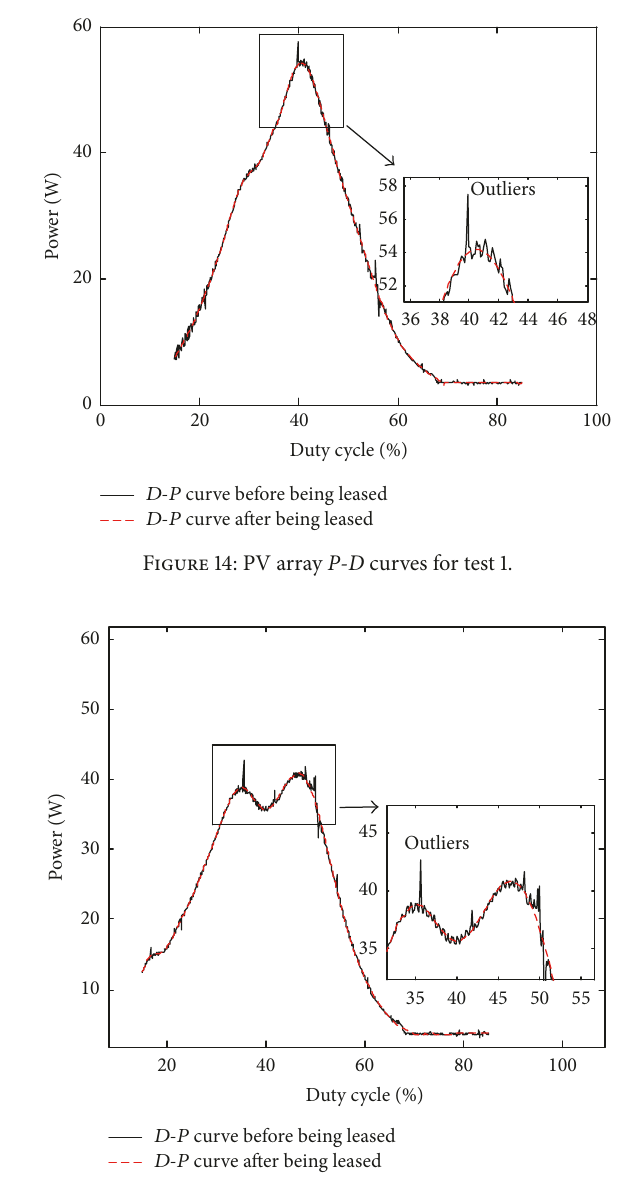
Figure 15: Photovoltaic array P - D curves for test